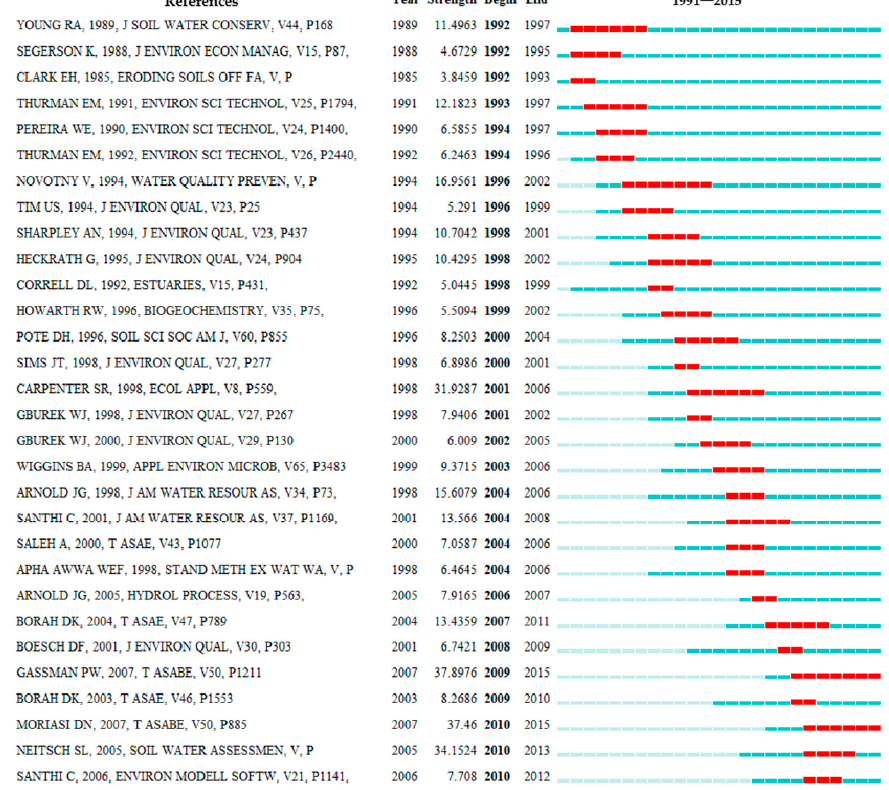
Figure 3. The top 30 references with the strongest citation bursts.